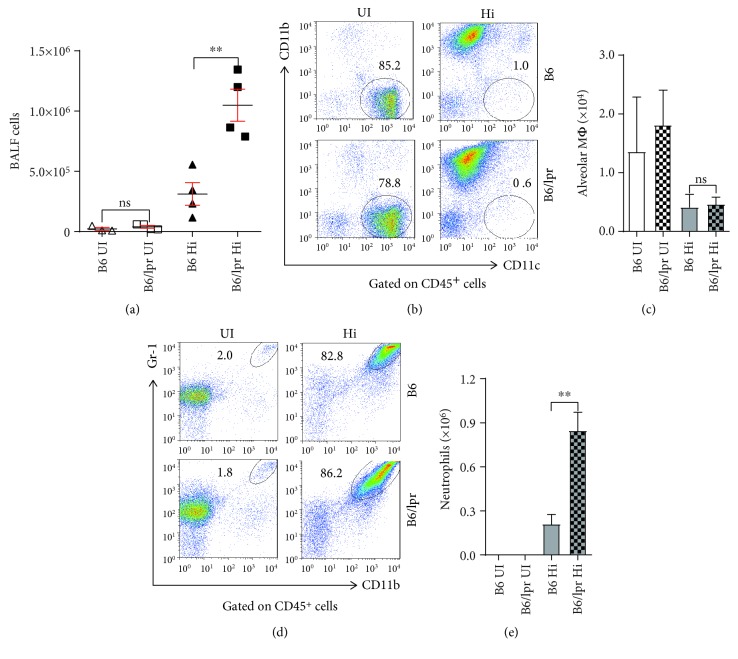
Tremendous neutrophils were recruited to the lupus lung after infection. B6 and B6/lpr mice were infected with Hi (B6 Hi and B6/lpr Hi). Uninfected mice were set as controls (B6 UI and B6/lpr UI). Two days after infection, all the mice were sacrificed and BALF cells were isolated for analyses. (a) Absolute numbers of BALF cells. (b, c) Alveolar macrophages (CD11b−CD11c+) and (d, e) neutrophils (CD11b+Gr-1+) were determined by surface staining. Data were expressed as means ± SEM. n = 3‐4 mice for each treatment group; ∗∗p < 0.01. ns: no significant difference. This experiment is representative of three individual experiments.